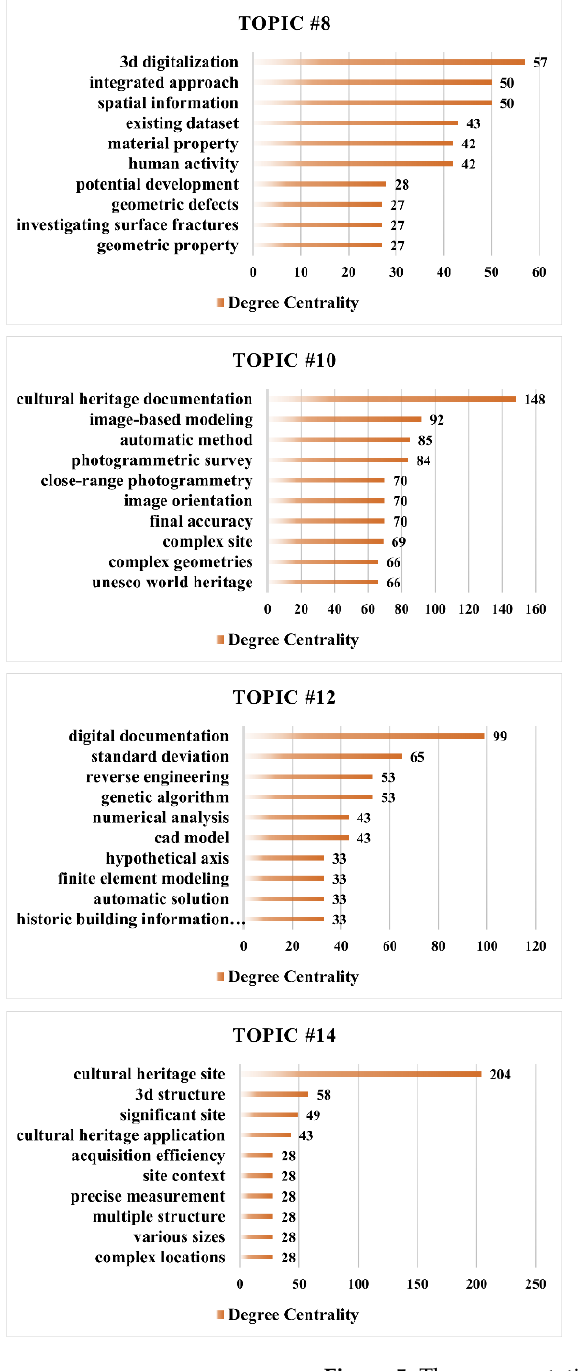
Figure 5. The representative terms of the top 16 clusters. Topic #2 labeled as “unmanned aerial vehicle photogrammetry”, Topic #3 labeled as “quick digital photogrammetric system”, Topic #10 labeled as “close-range automatic correlation photogrammetry”, Topic #13 labeled as “tls data” and Topic #15 labeled as “mobile lidar system” are all related to the technical approaches of 3D point cloud data acquisition. The average research years of the above topics is relatively early because point cloud data acquisition is the primary task in the research field. Different topics reflect the distinctive technical characteristics of point cloud data acquisition methods in cultural heritage. For example, the term “global navigation system” is included in the topic